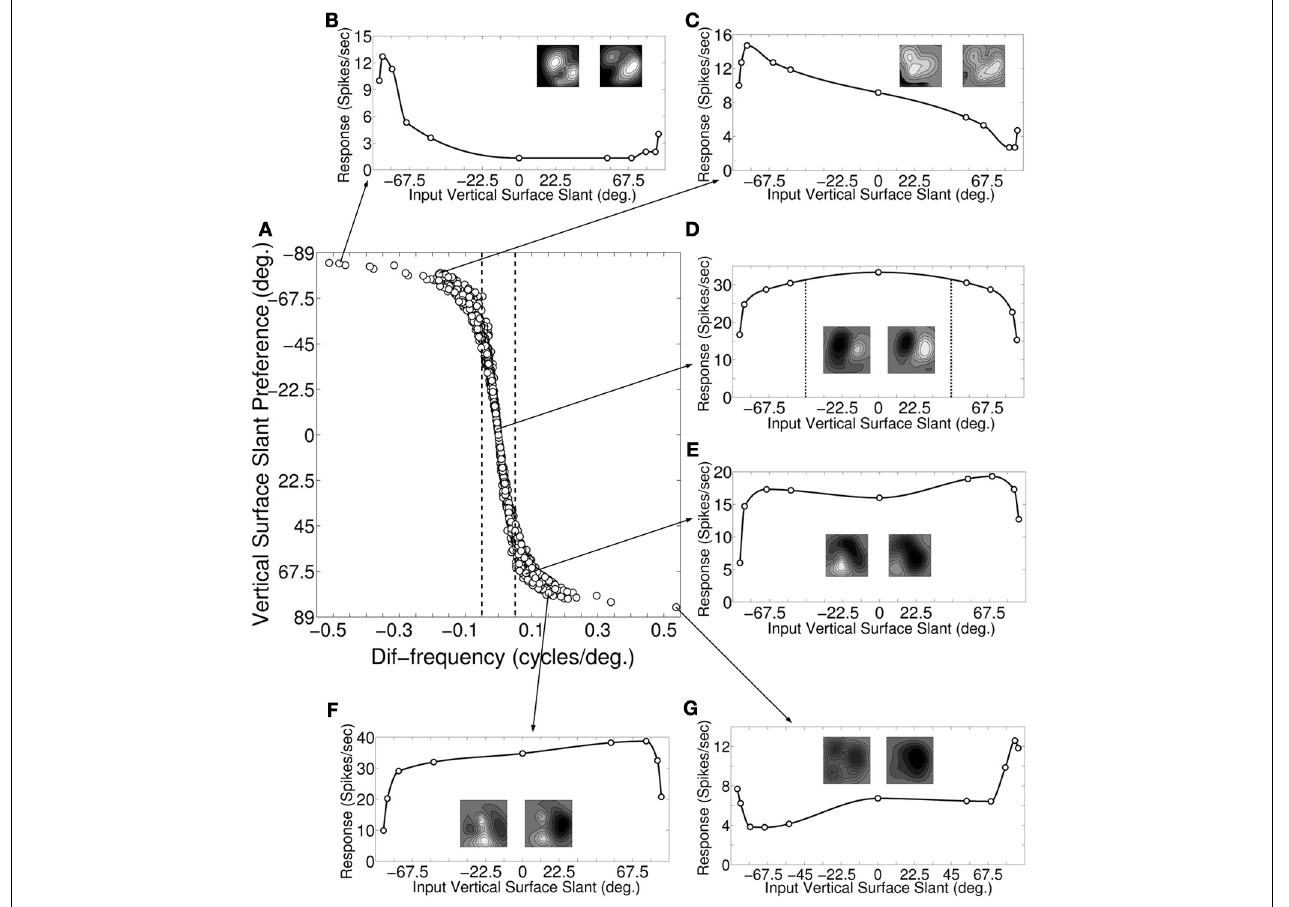
| dif-frequency | = 0 . 05 cycles/degree. (B–G) Depicts vertical surface slant tuning for six sample cells along with their monocular receptive fields. The arrowlinesindicatewherethesesamplecellsarelocatedinthescatterplot (A)